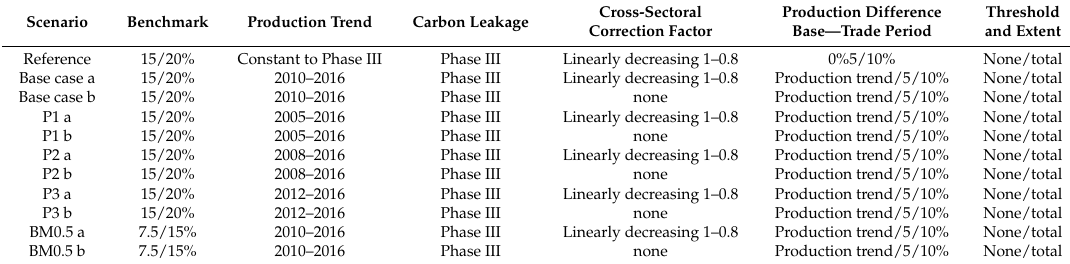
Table 1. Scenario overview.